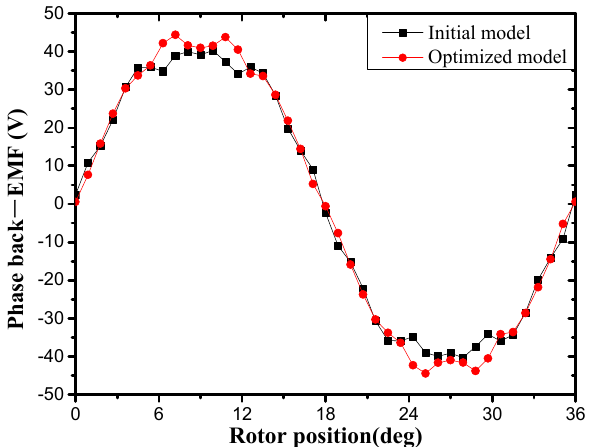
Figure 23. Phase back － EMF of the initial model and the optimized model.